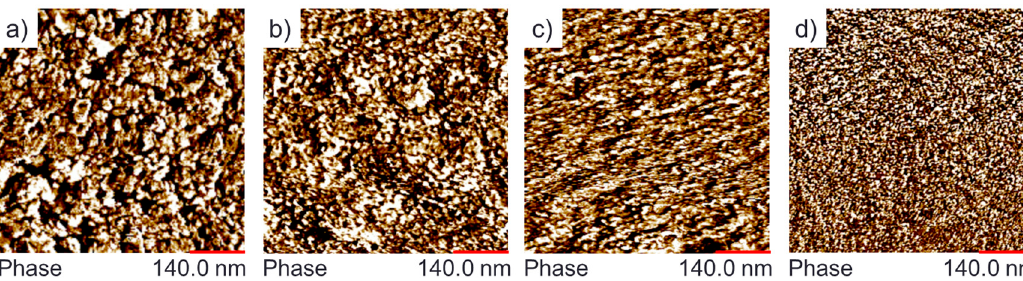
Figure 7. AFM phase images of ( a ) QN-PAES X10Y23, ( b ) QN-PAES X10Y13, ( c ) QN-PAES X19Y23, and ( d ) QN-PAES X19Y13. Table 5. Scattering vector and Bragg spacing of the QN-PAES membranes calculated from SAXS data.